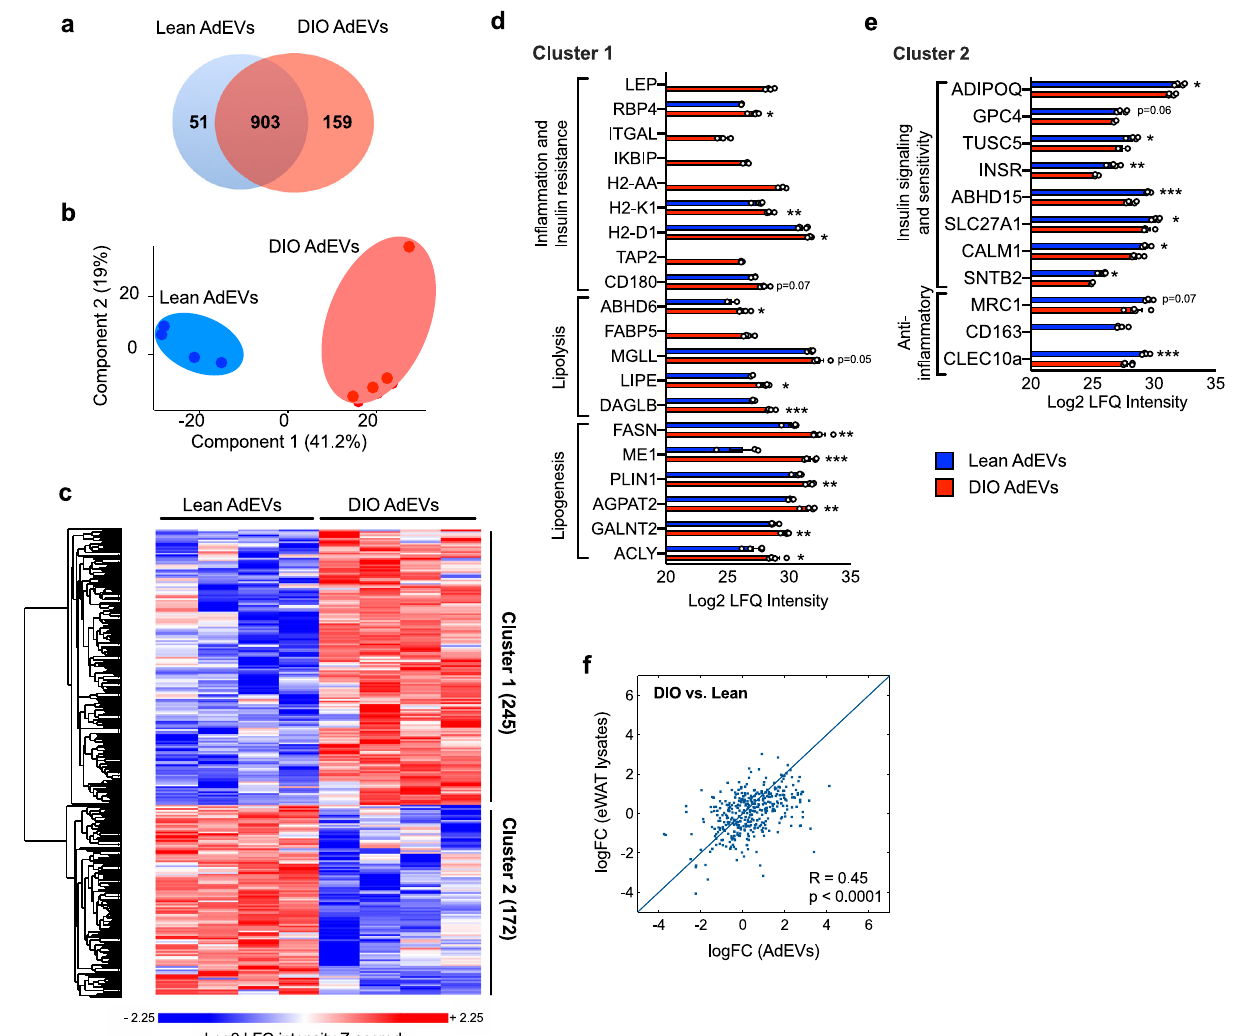
Fig. 2 | AdEV protein cargo in leanand DIO mice. AdEVs from leanand DIOmice ( n =4 independent AdEV replicate samples. Each AdEV sample was isolated from pooled visceral fat pads of 5 DIO or 10 lean male 6-8 months old C57BL/6J mice subjected to 4-6 months of HFD or chow) were subjected to LC – MS/MS-based proteomics. a Venn Diagramand b principalcomponent analysis(PCA) of proteins identi fi edinleanand/orDIOAdEVs. c Heatmapofz-scoredproteinintensitiesforall uncovered proteins (ANOVA, FDR<0.01), and d , e average Log2 LFQ intensities (±SEM) of selected proteins with different abundance in lean and DIO AdEVs. d Cluster 1: proteins involved in in fl ammation, insulin resistance, lipolysis and lipogenesis; e Cluster 2: proteins involved in anti-in fl ammatory responses, insulin signaling and sensitivity. f Correlation of log Fold Change (logFC) as derived from the difference(DIO vs. lean) in the expression levels of 371 eWATlysates and AdEV proteins(Pearsoncorrelationcoef fi cientis0.4520). d , e